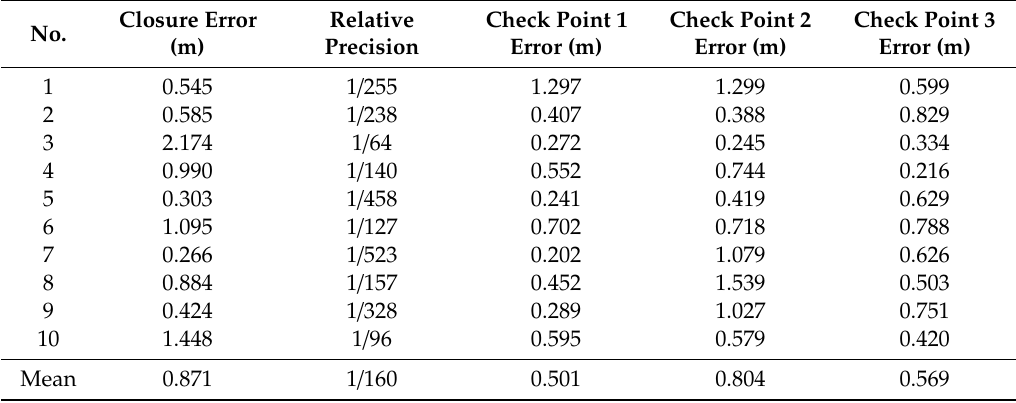
Table 4. Modified particle filter method.